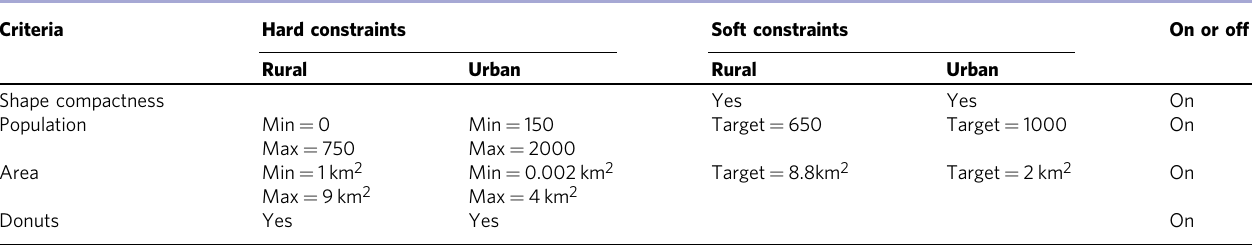
Table 2 Illustrates the criteria were set in AZTool to generate sensible EAs in Somalia ’ s rural and urban (Mogadishu and Hargeysa cities)